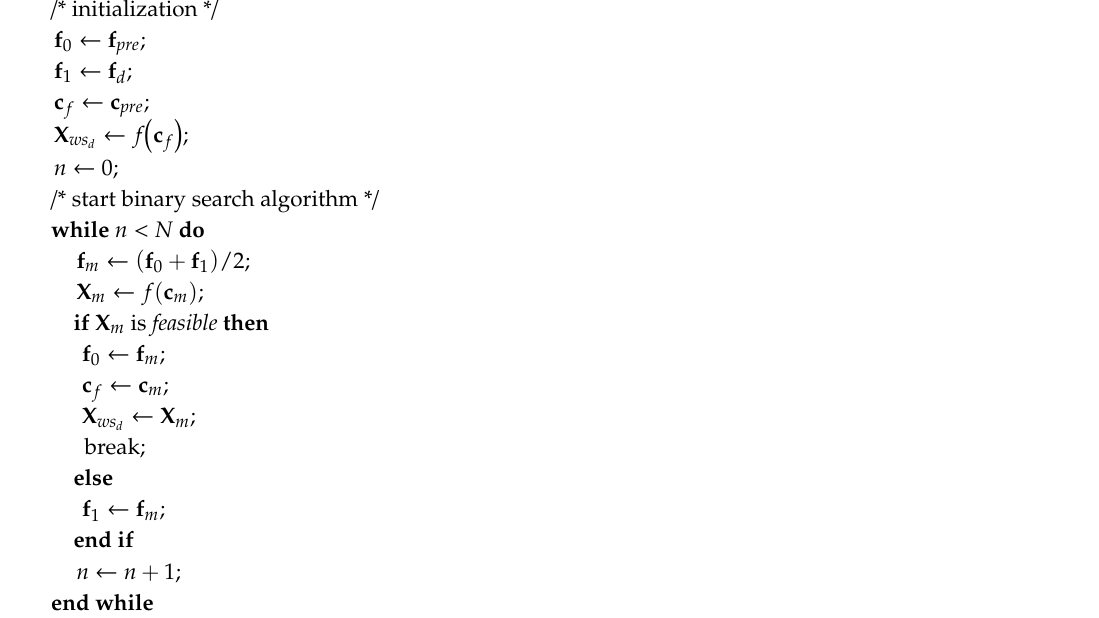
Algorithm 1. Handling infeasible command states and desired walking